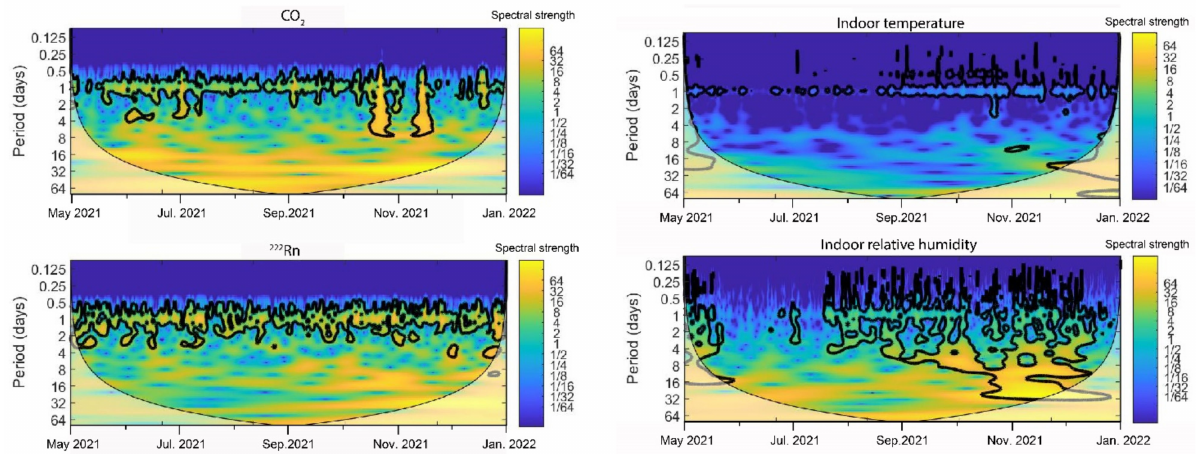
Figure 3. Decomposition of different periodicities for CO 2 , 222 Rn, indoor temperature and indoor relative humidity.